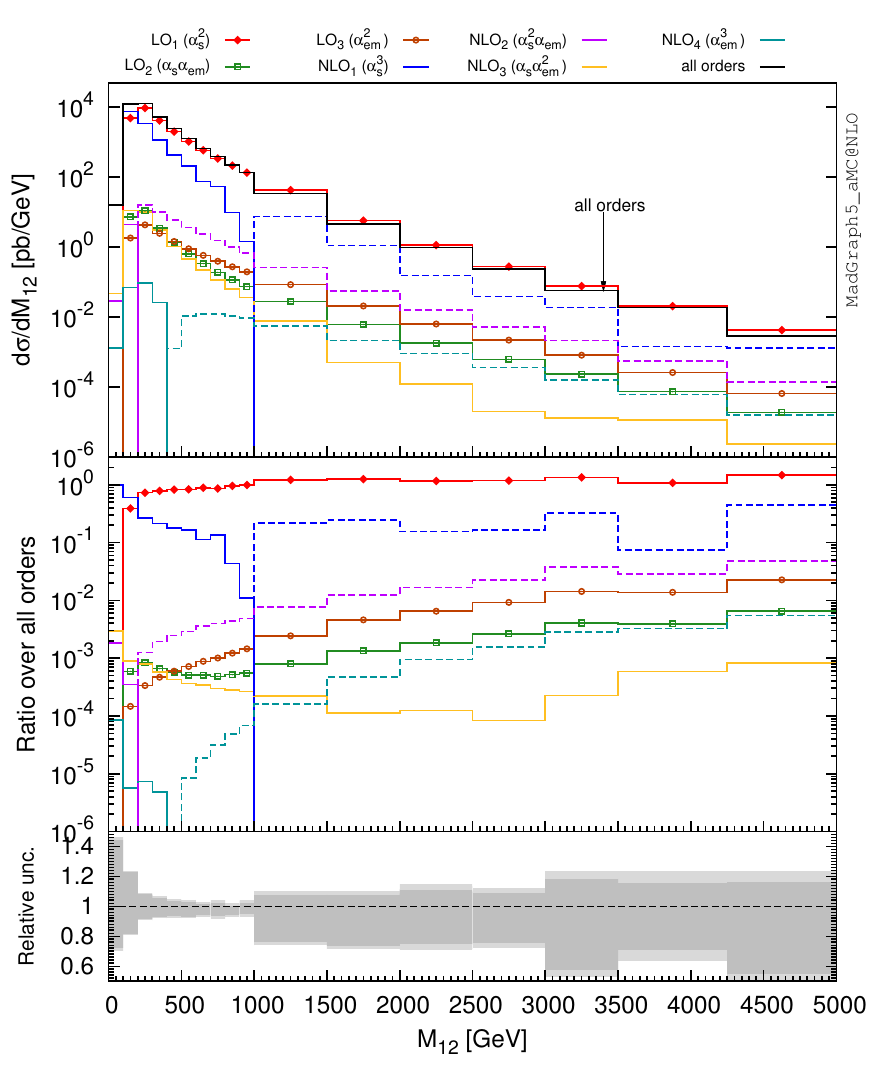
Figure 11 . Invariant mass of the hardest jet